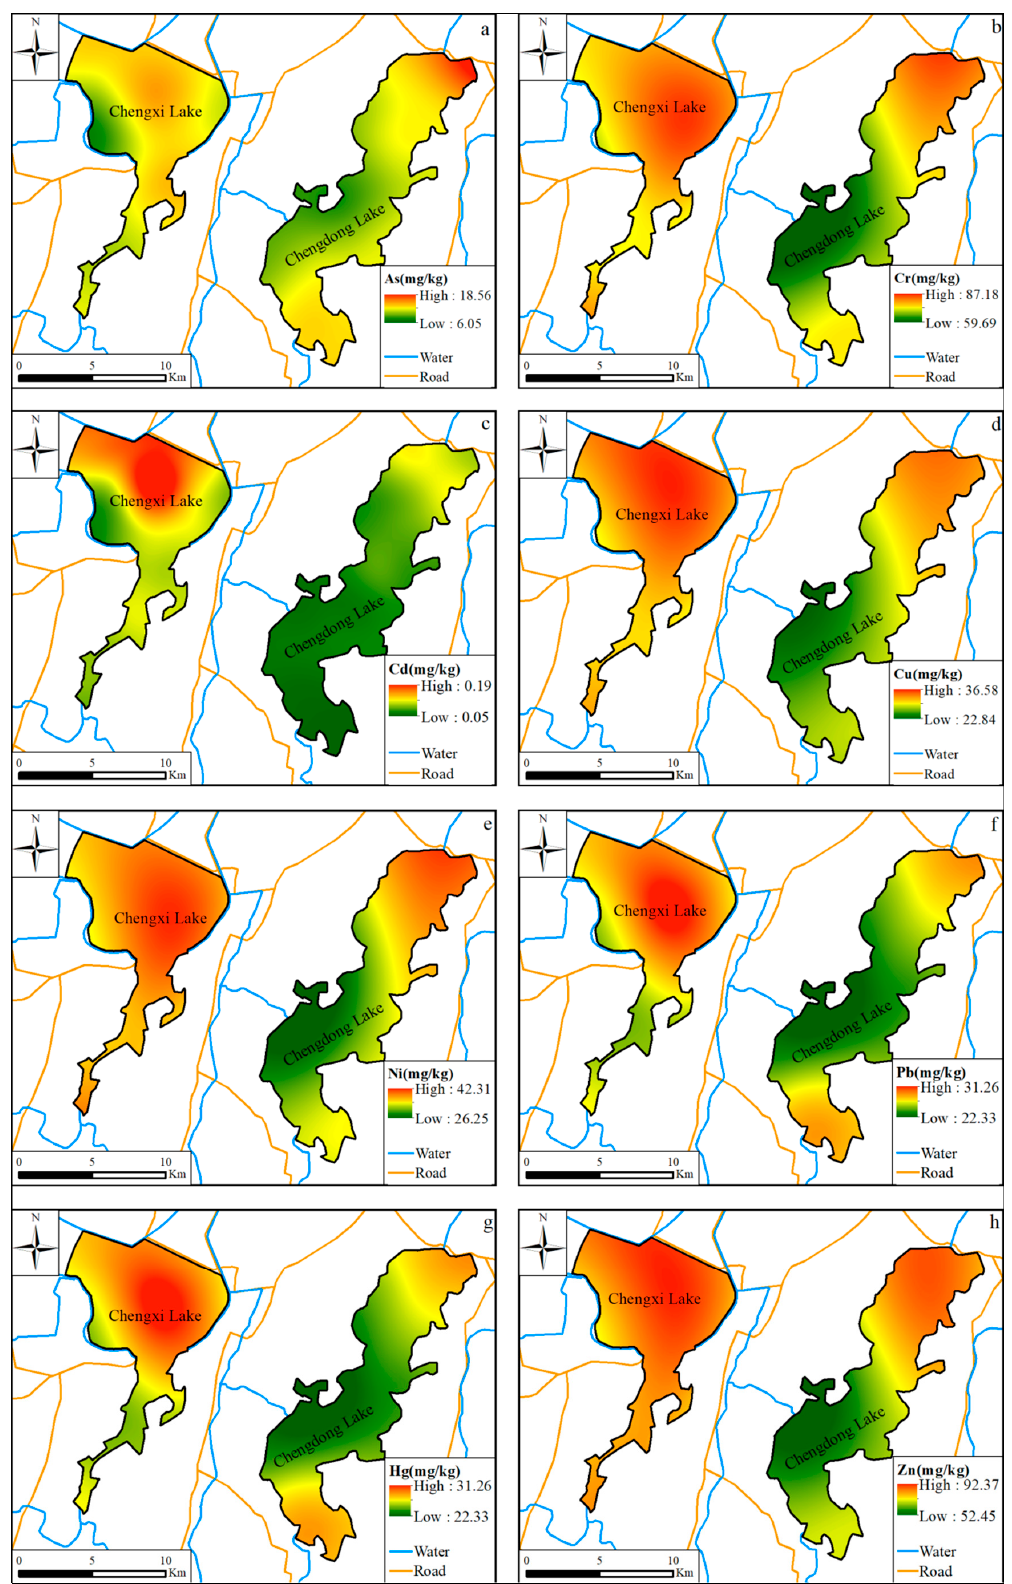
Figure 2. Spatial distribution of heavy metals in sediments of lake in study area. ( a ) As; ( b ) Cr; ( c ) Cd; ( d ) Cu; ( e ) Ni; ( f ) Pb; ( g ) Hg; ( h ) Zn. This figure was drawn with ARCGIS